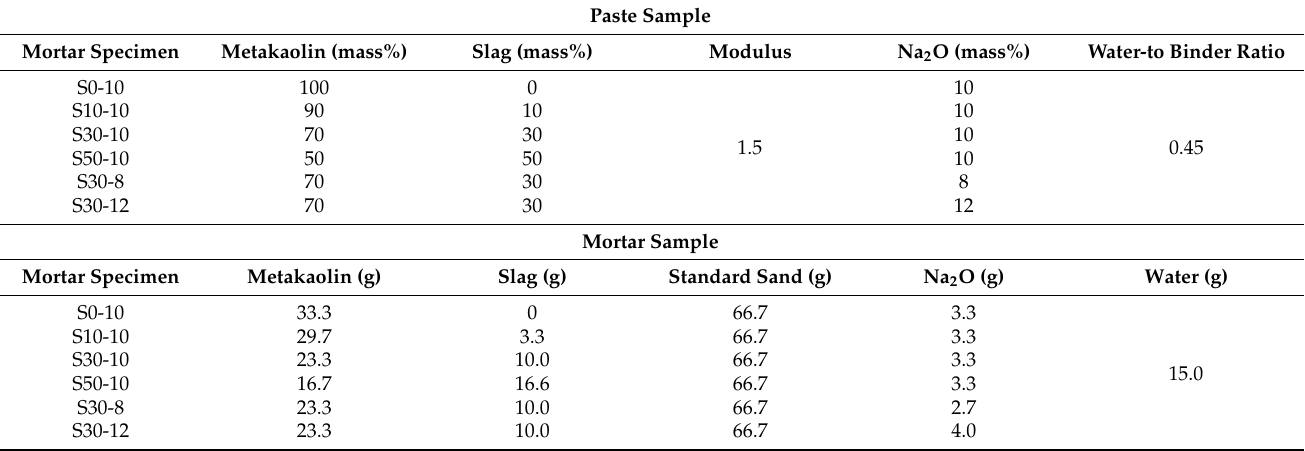
Table 2. Mixture proportions of the alkali-activated metakaolin-based